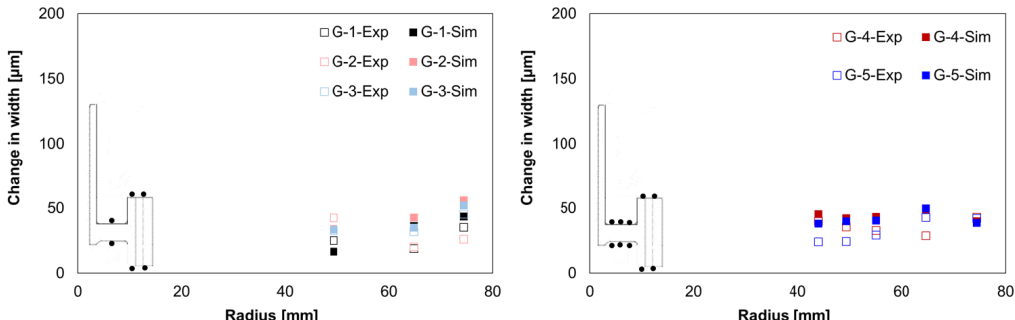
Figure 11. Comparison of the measured and calculated width changes for G1–G3 ( left ) and G4–G5 ( right ).